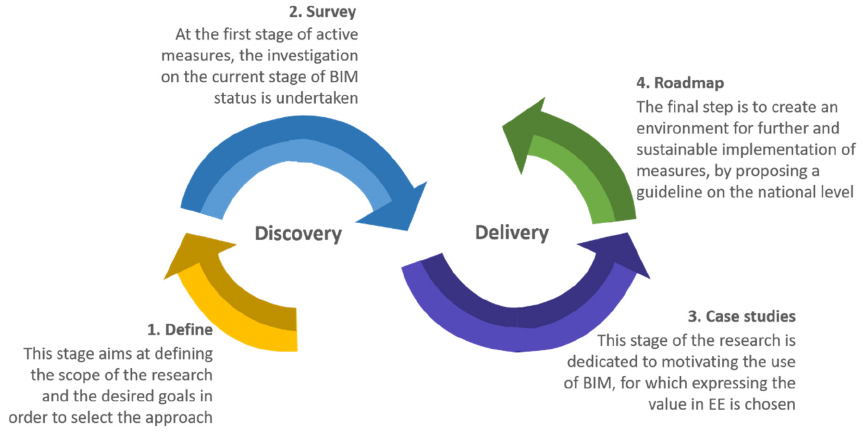
Figure 2. Specific aims of the paper presented as successive steps in a process